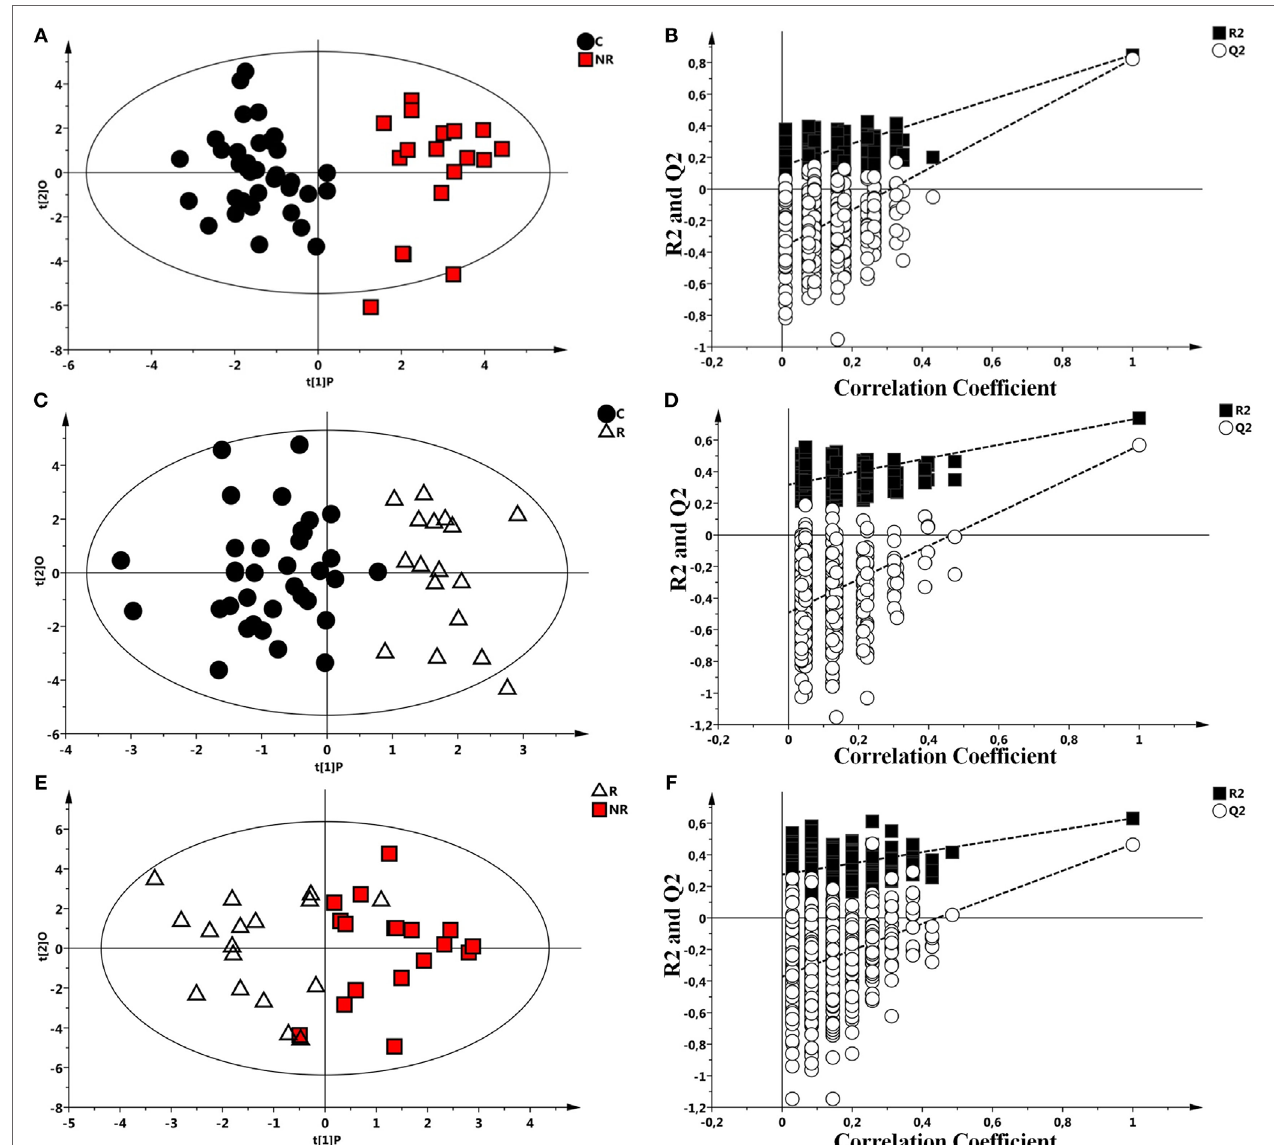
FigUre 2 | Scores plots obtained from nuclear magnetic resonance spectra of serum samples from controls and responder (R) and non-responder (NR) patients. (a) Scores plot from the multivariate orthogonal partial least square discriminant analysis (OPLS-DA) model between controls ( ● ) and NR patients ( ◾ ). (B) Statistical validation of the corresponding model by permutation test ( n = 500). (c) OPLS-DA between controls ( ● ) and R patient ( Δ ) and (D) statistical validation of the corresponding model by permutation test ( n = 500). (e) OPLS-DA model between R ( Δ ) and NR patients ( ◾ ). (F) Statistical validation of the corresponding model by permutation test ( n =